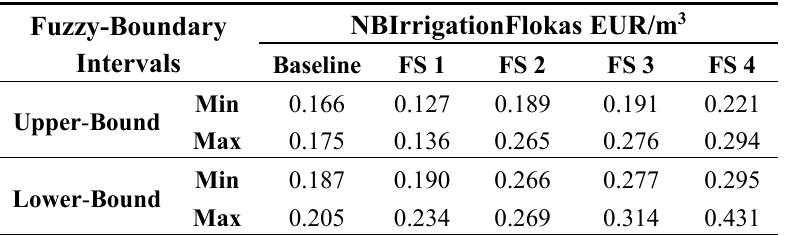
Table 5. Lower- and upper- fuzzy-boundary intervals for the unit benefit from irrigation for the baseline and the WADI future scenarios for Flokas irrigation scheme EUR/m 3 .